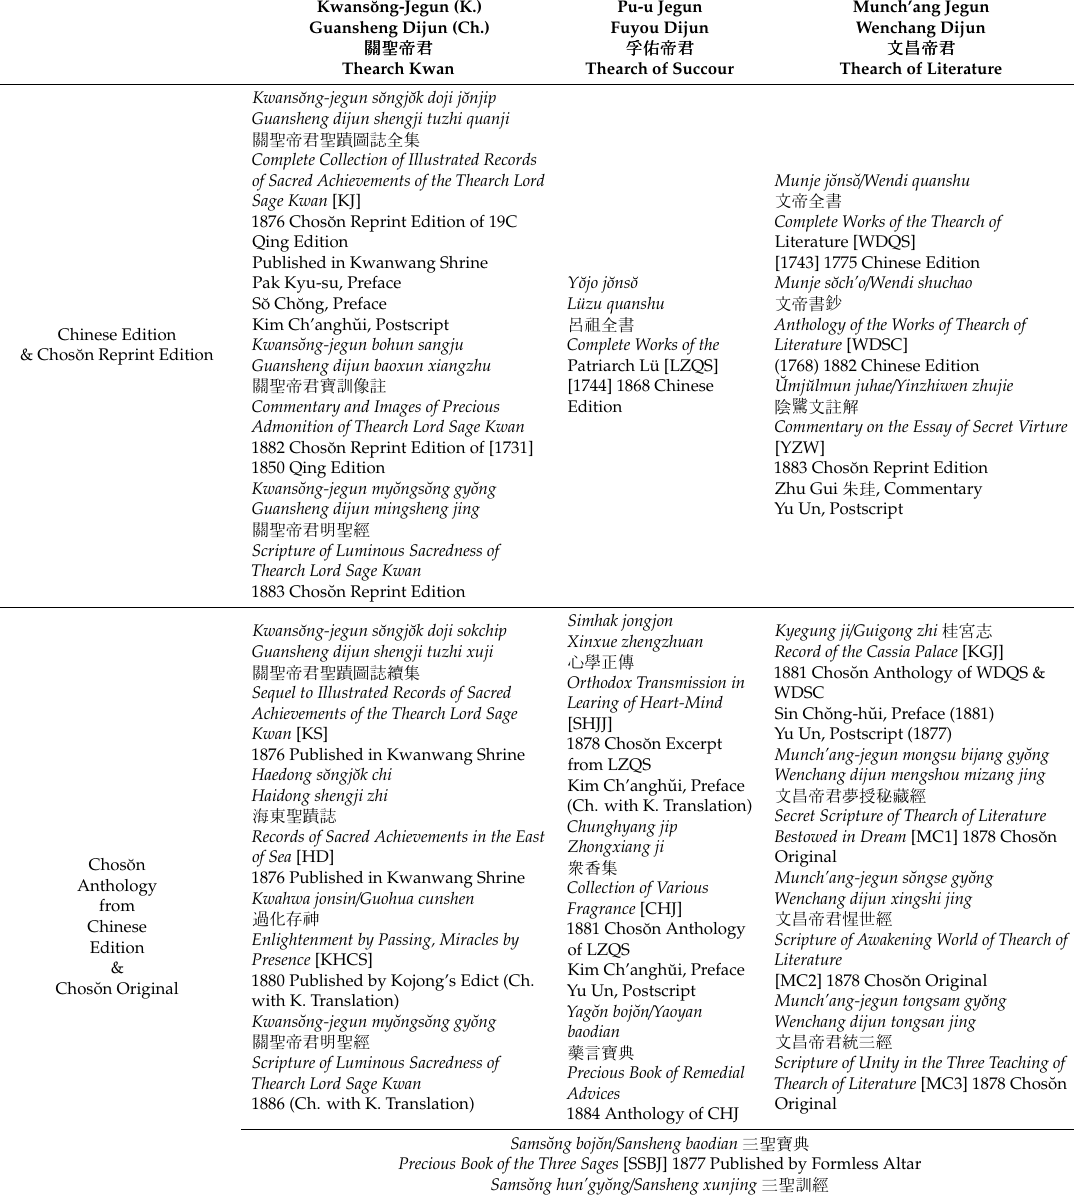
Table 2. Publication of Scriptures of the Three